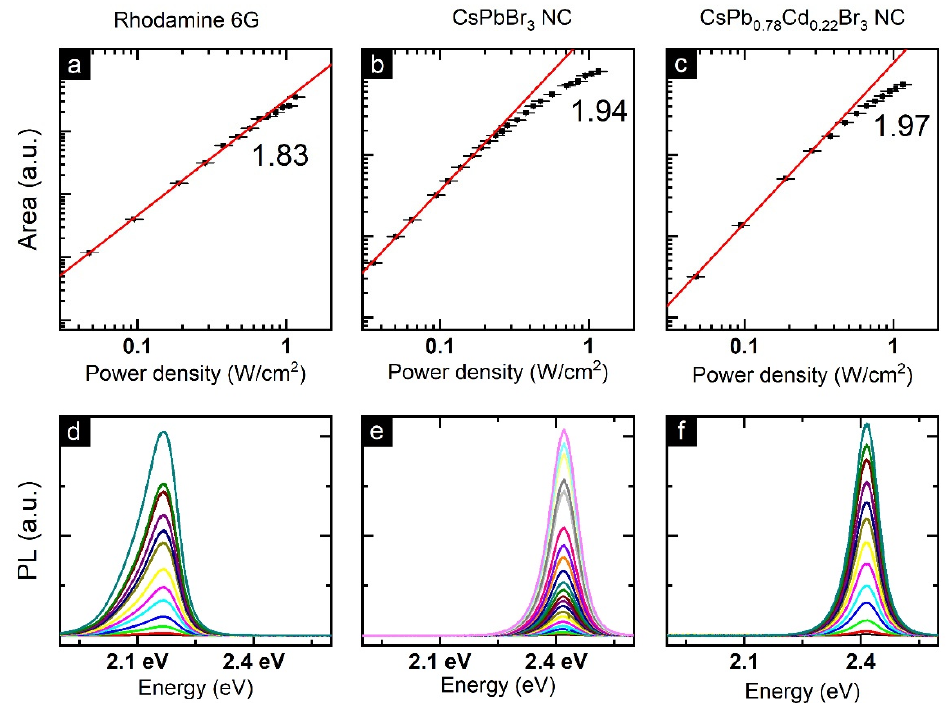
Figure 4. The log–log plots of integrated PL area vs. power density for Rhodamine 6G ( a ), CsPbBr 3 NCs ( b ), and CsPb 0.78 Cd 0.22 Br 3 NCs ( c ). ( d – f ) corresponding 2PA-excited PL spectra measured at different excitation power densities.